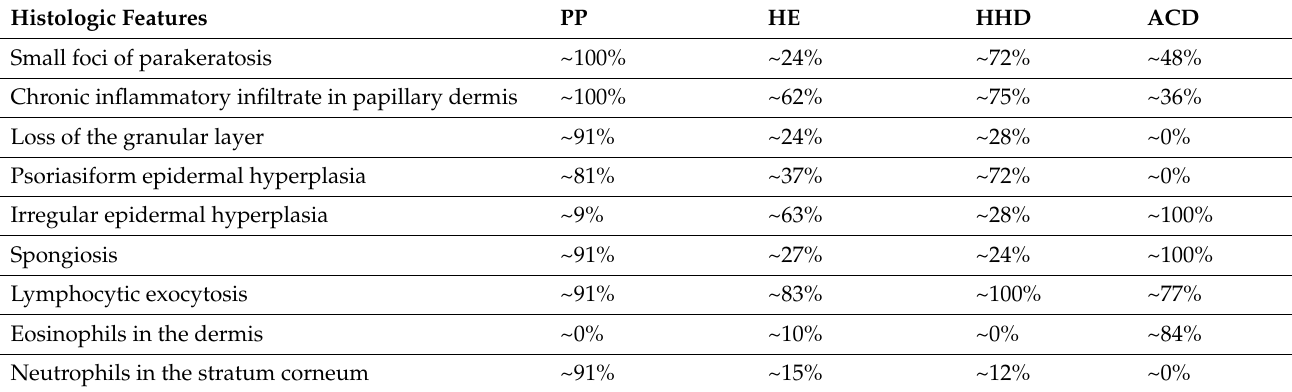
Table 2. Histologic differential diagnosis